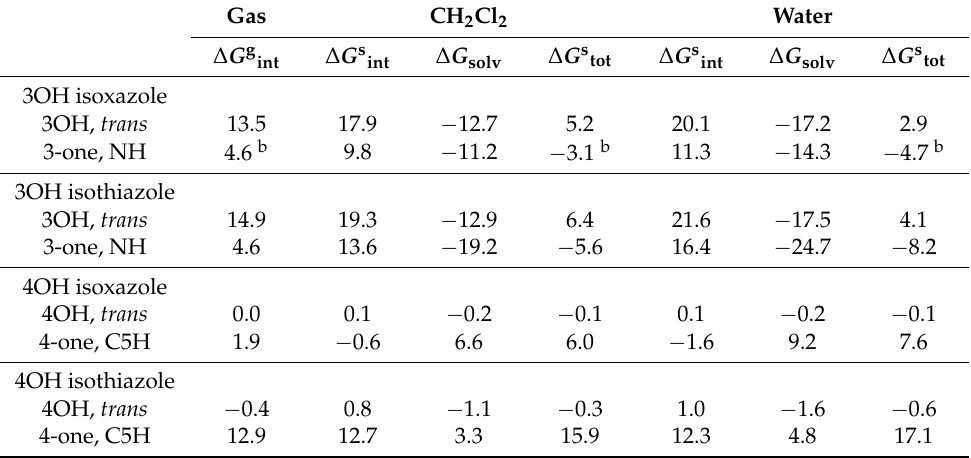
Table 2. Relative free energies for the conformers/tautomers of the isoxazole and isothiazole OH derivatives. Energies in kJ/mol relative to the corresponding cis OH species a . Gas CH 2 Cl 2